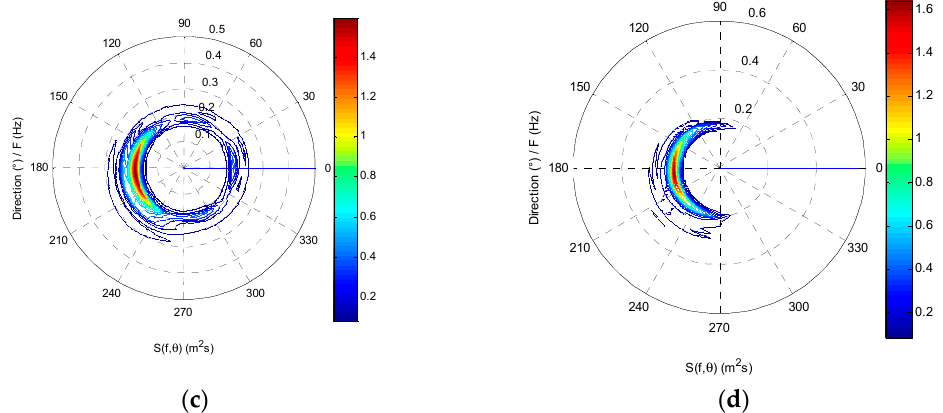
Figure 11. Comparison of directional wave spectrum between the SBF7-1A GPS wave buoy and the DWR-MKIII Waverider buoy after correction at 03:00 (UTC) on 2 July 2013: ( a , c ) directional wave spectrum of the SBF7-1A GPS wave buoy; ( b , d ) directional wave spectrum of the DWR-MKIII Waverider buoy.